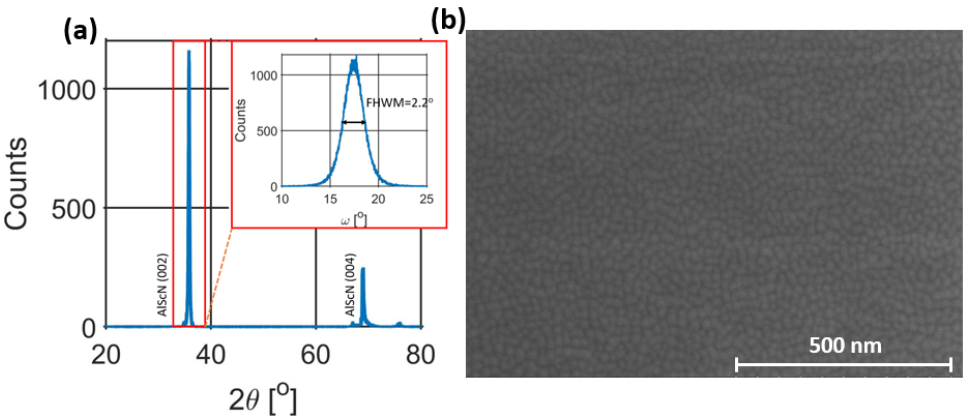
Figure 5. ( a ) XRD 2 Θ scan patterns with Rocking curves of 002 Al 72 Sc 28 N diffraction peaks shown in the inset. ( b ) SEM micrograph of Al 72 Sc 28 N